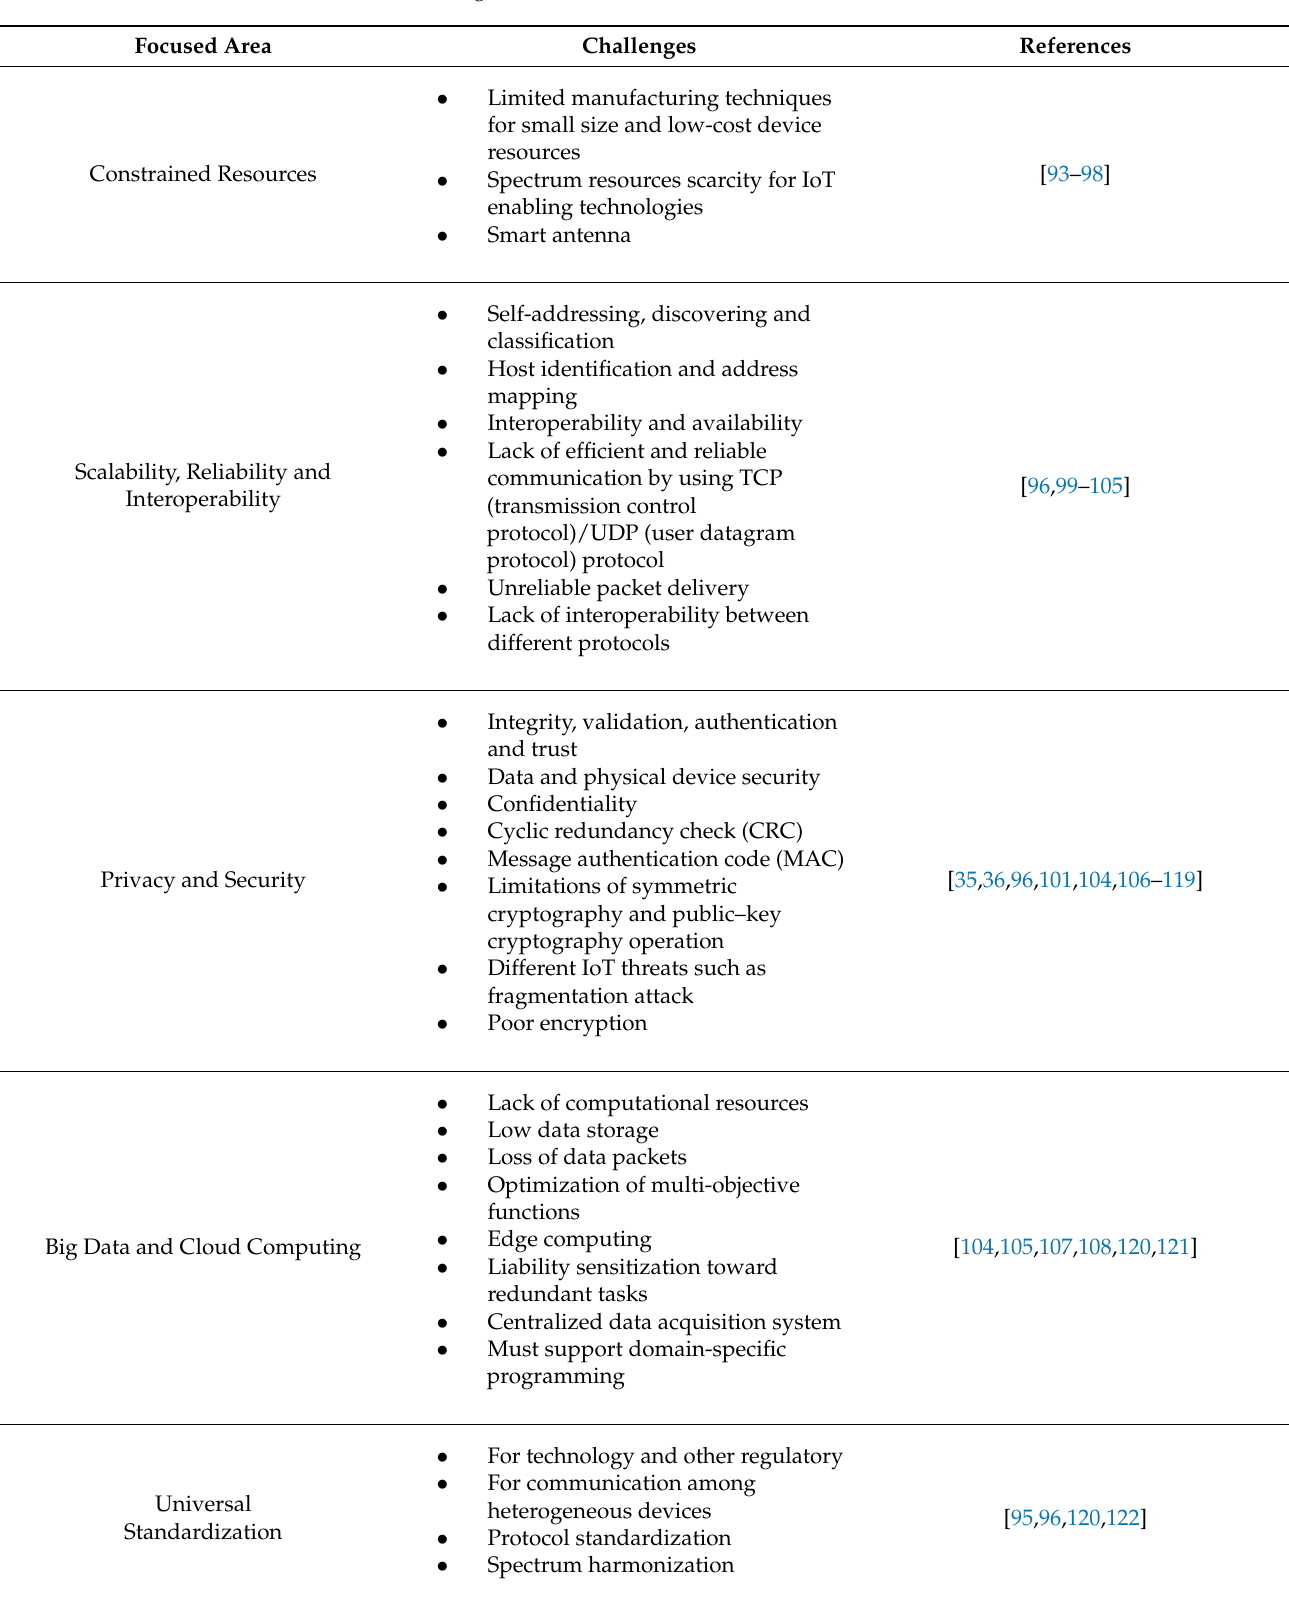
Table 3. Challenges of the